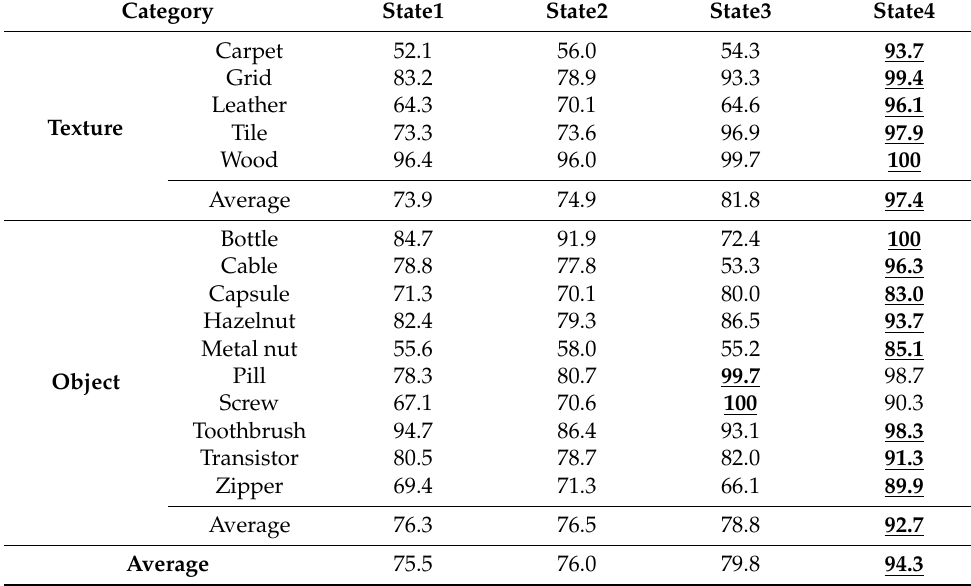
Table 3. The AUC values of every sub-module on the MVTec dataset. Hereby, the influence of every sub-module on the anomaly detection task is illustrated. The results in bold and underlined are the best AUC